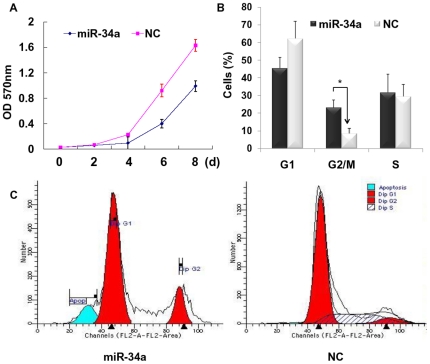
MiR-34a induced growth inhibition in rat hepatocytes.(A) BRL-3A cells treated with miR-34a mimics (miR-34a) or negative control (NC) were seeded in 96-well plates and examined at indicated time points. The absorbance of methylthiazoletetrazolium by each sample was recorded at 570 nm after staining. (B,C) Cells treated with miR-34a or NC were analyzed by flow cytometry as described in “Materials and methods” for cell cycle distribution analysis.